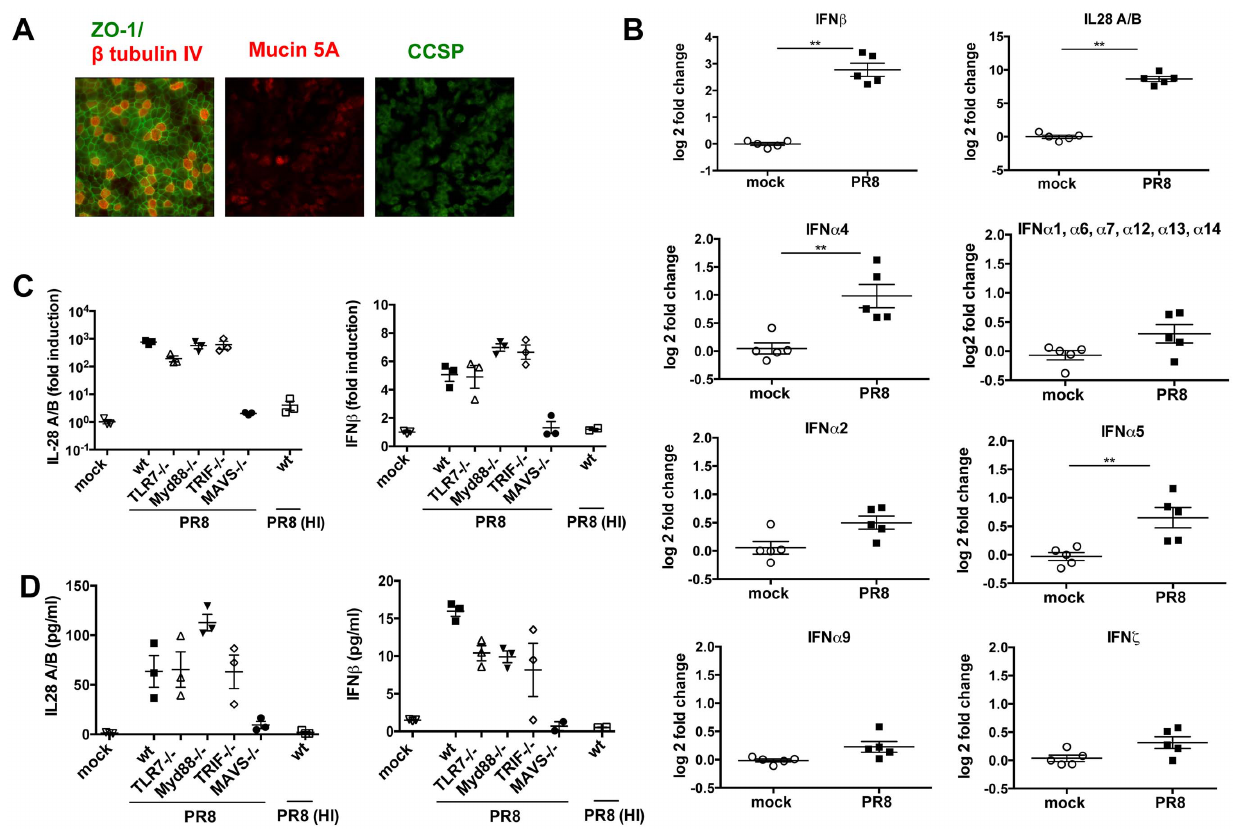
Figure 1. In primary MTEC, type I and III IFNs are induced upon influenza virus A infection, in a MAVS and replication dependent way. (A) Mouse tracheal epithelial cells were costained for ZO-1 (green) and b tubulin IV (red), or Mucin 5A (red) and Clara cell secretory protein (CCSP) (green). Images were acquired at 6 20 magnification. (B) Total RNA from mock infected and PR8 infected (moi=0.3) MTEC was analysed using Affymetrix Mouse Genome 430 2.0 microarrays. The signal intensity of each probe was first normalized on the median intensity of that probe across the control group and then represented as log2 fold change relative to the controls. Asterisks indicated statistically significant differences (unpaired t test; **, p , 0.01). (C) qRT-PCR analysis of IL-28A/B and IFN b 1 transcripts of MTEC derived from wild-type, TLR7 2 / 2 , MyD88 2 / 2 , TRIF 2 / 2 and MAVS 2 / 2 mice, mock infected or infected with either PR8 or heat inactivated PR8. Fold induction is relative to mock treated samples at 24 hpi + / 2 SEM. (D) IL- 28A/B level in the supernatants of the indicated cultures were measured by ELISA 24